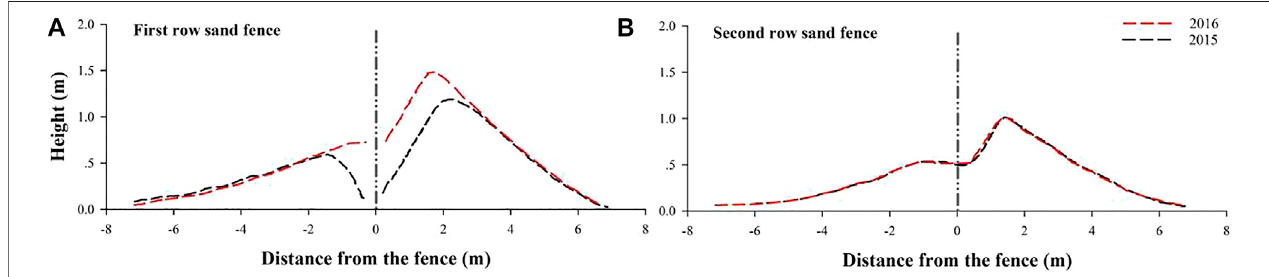
FIGURE 10 | Morphology of the deposited sand on the windward and leeward sides of the (A) fi rst and (B) second concrete plate-insert sand fences (CPISFs) in 2015 and 2016. The red and black dashed lines show the dune shapes in 2016 and 2015, respectively.